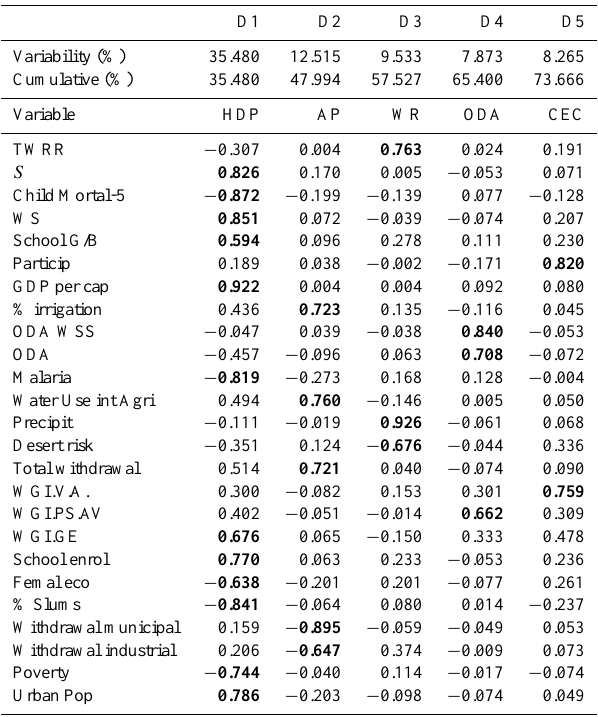
Table 4. Rotated FA factors matrix with principal component as extraction method, varimax rotation and Kaiser normalization. The five components explain more than 73% of the variability. In bold, the highest factor